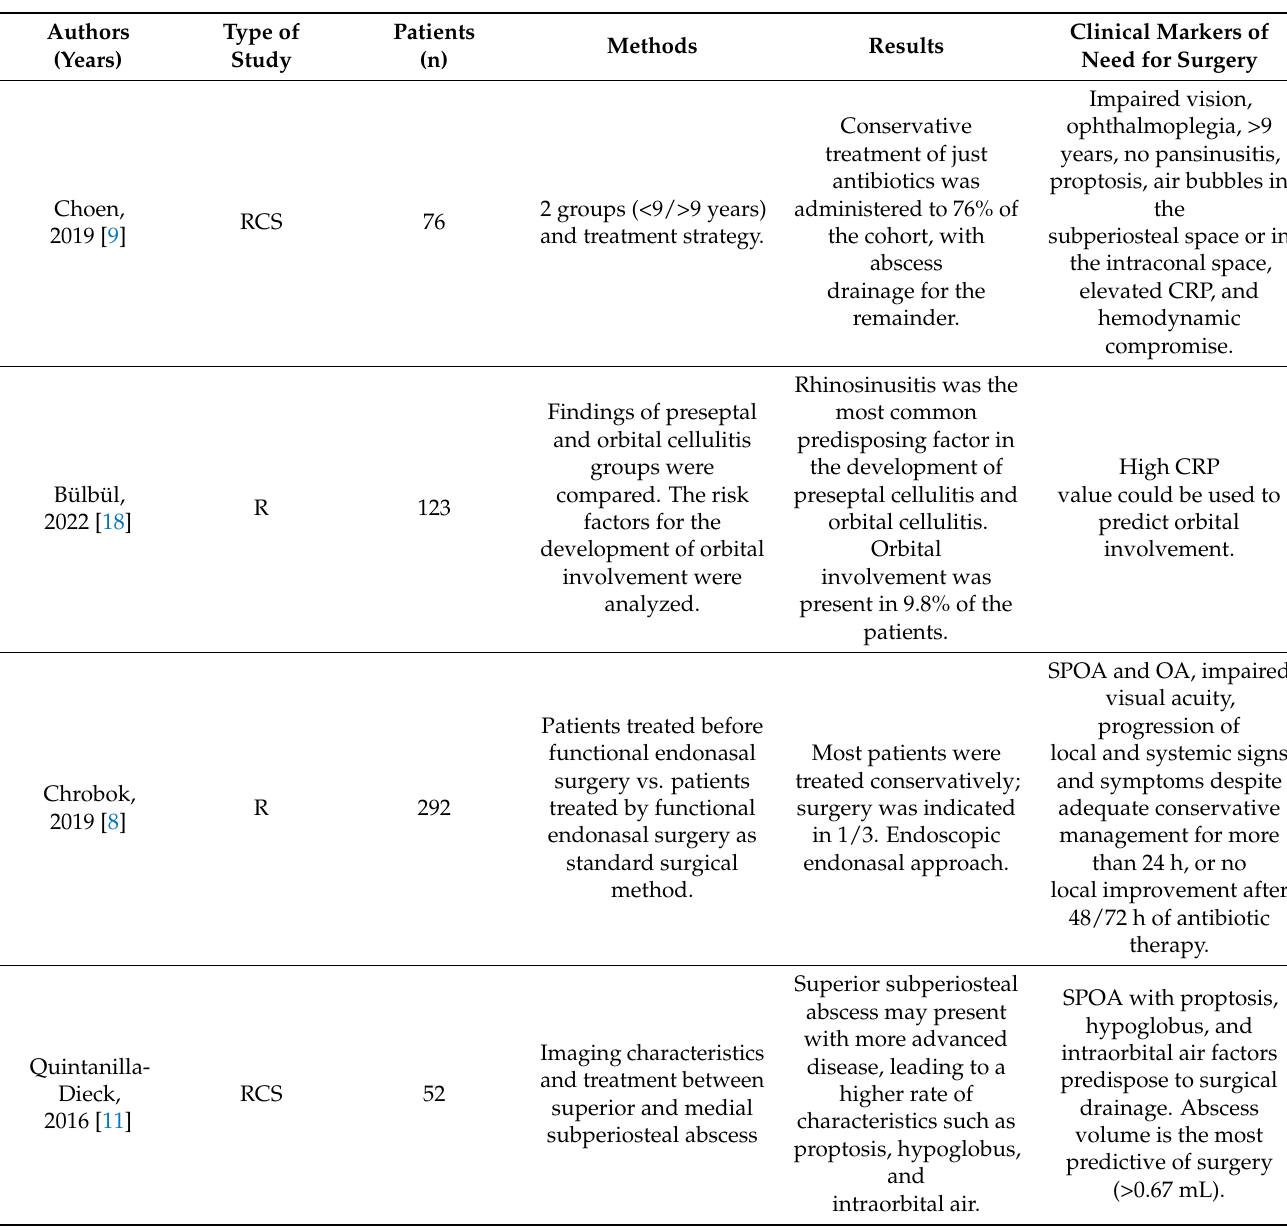
Table 1. Articles included in the qualitative analysis and